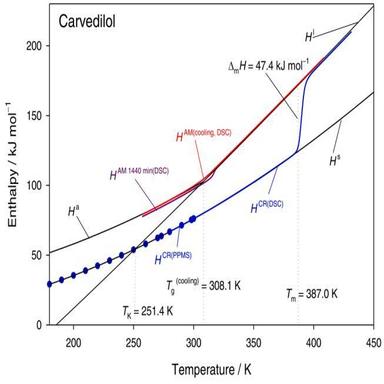
Experimental, enthalpy of crystalline, HCR(DSC) and amorphous, unaged HAM(cooling, DSC), aged at 403.15 K for 1440 min, HAM 1440 min(DSC), carvedilol as measured by DSC in the frame of calculated enthalpy in the solid, Hs , and liquid, Hl , states. The symbols are described in the main text.